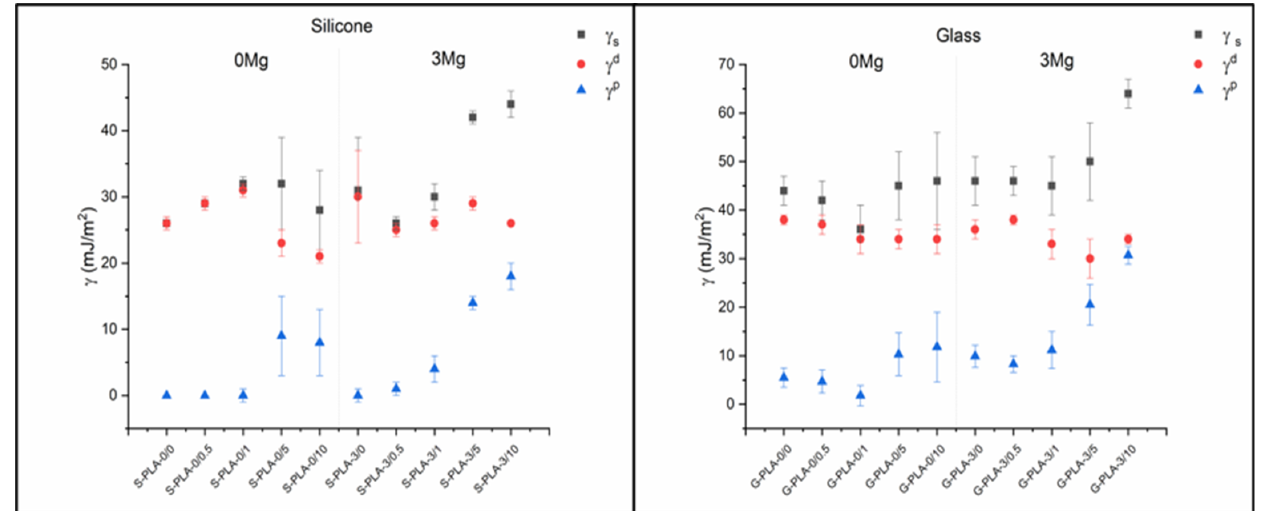
Figure 2. Surface tension ( γ S ) and dispersive ( γ d ) and polar ( γ p ) components calculated using the Fowkes model.